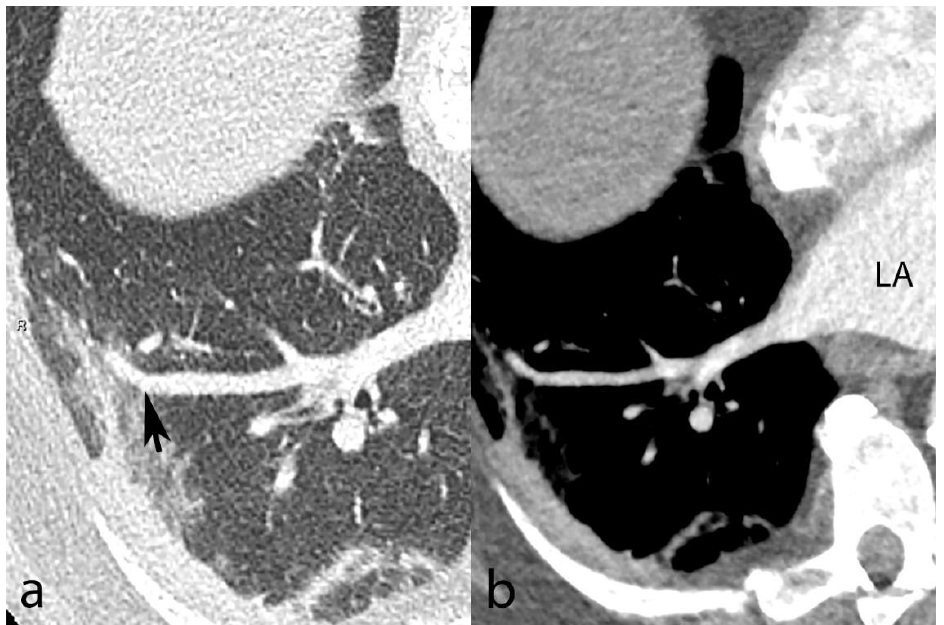
Figure 3. Contrast-enhanced chest CT from a 67-year-old male shows SARS-CoV-2 pneumonia with mixed peripheral ground-glass opacities and consolidation in the right lower lobe. Venous congestion is seen in the apical segment (panel ( a ), black arrow). A reformatted oblique axial image with mediastinal window settings (panel ( b )) demonstrates the venous nature of the dilated vessel based on its connection to the left atrium (LA). Table 2. Anatomical distribution of pulmonary emboli (n = 329) in upper, middle, and lower pulmonary segments (20 segments in 61 patients).